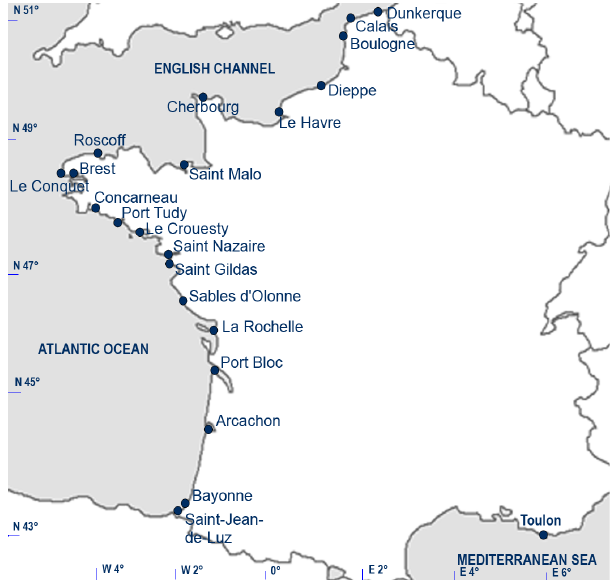
Fig. 1. Exponential fitting of the data set of surges at Brest (1846– 2009). The 70% and 95% lines correspond to confidence intervals, the surge levels are in centimeters, and the return periods in years. The surge of 144cm in height corresponding to the storm of 1987 is significantly different from the other surges of the sample; the theoretical distribution is not satisfying for this event.